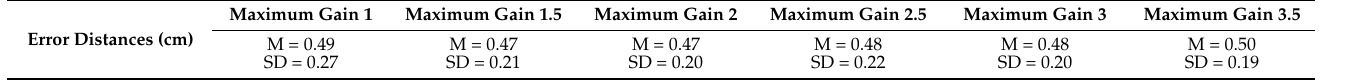
Figure 5. Error distances based on the maximum CD gains.